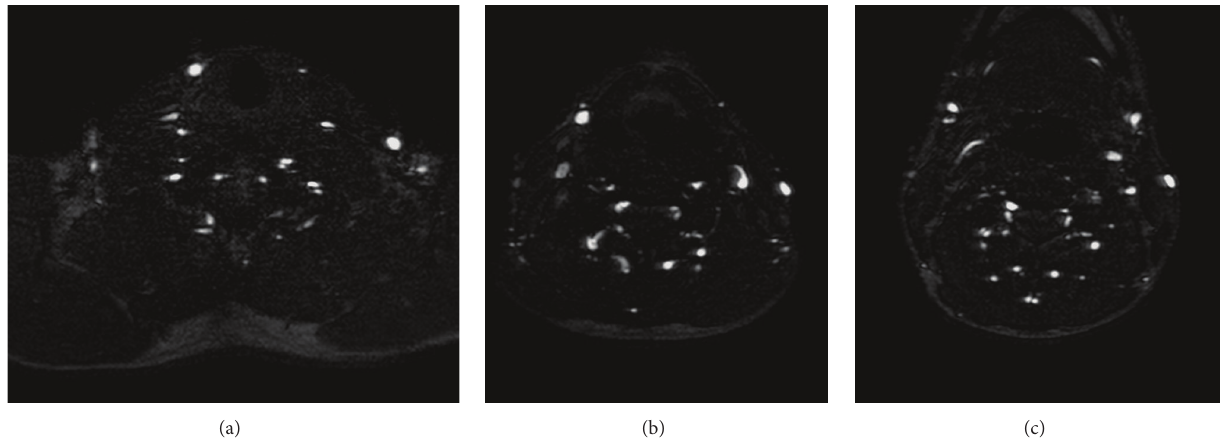
Figure 2: Extracranial 2D TOF: axial slices at different neck levels, (a) at the neck basis, (b) at midneck level (C5-C6 level), and (c) at an immediately submandibular level (C4-C5 level), showing patency of the IJV system bilaterally, as that of anterior jugular veins (with right side prominence) and vertebral venous